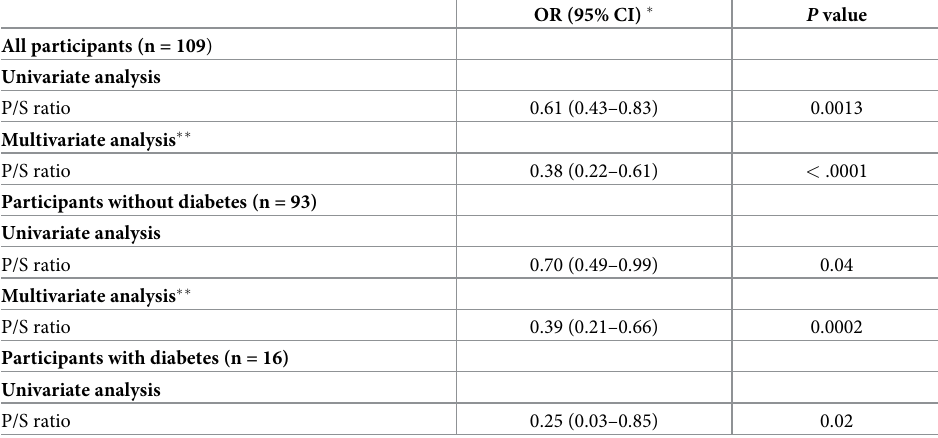
Table 2. Association between pancreatic endocrine impairment and the amount of pancreatic